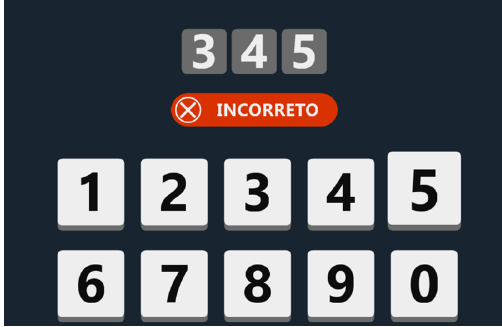
Fig. 2. Print screen of an incorrect answer of a sequence of numbers.